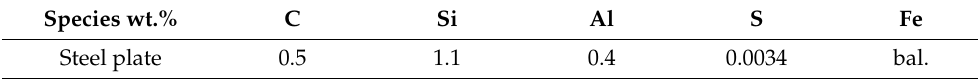
Table 2. Chemical analysis of investigated steel analyzed by optical emissions spectrometer (OES). Species wt.% C Si Al S Fe Steel plate 0.5 1.1 0.4 0.0034